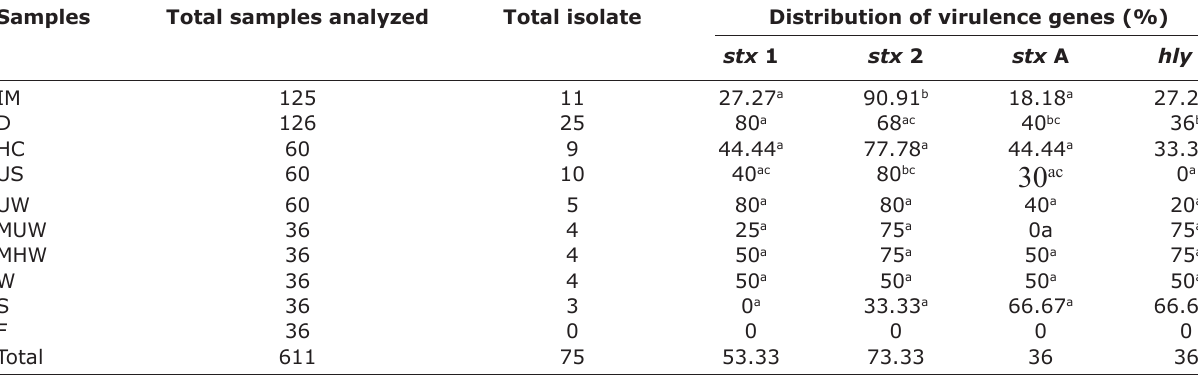
Table-3: Occurrence of EHEC virulence genes (%) in different samples.